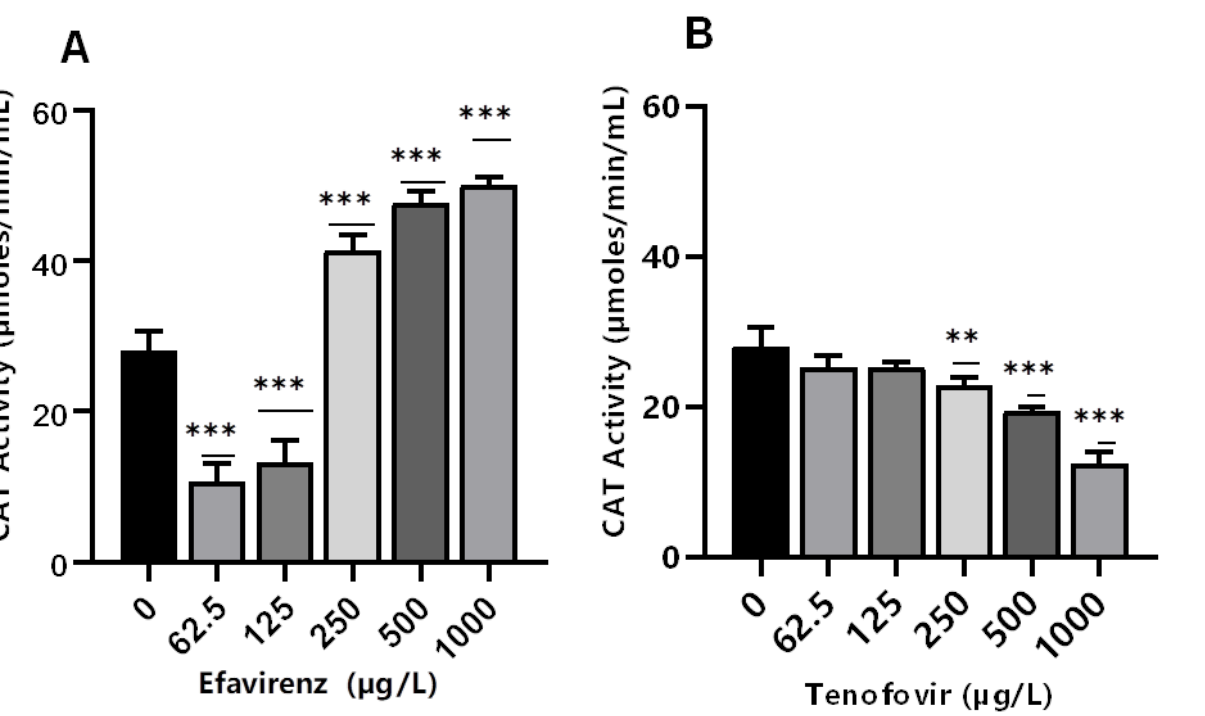
Figure 2. Catalase activity levels in D. magna exposed to ( A ) EFV, and ( B ) TFV for 48 h. Values are presented as mean ± standard deviation ( n = 3); (Asterisks (*) denote significant differences (one-way ANOVA followed by Dunnett’s multiple comparisons test (** p ≤ 0.01, *** p ≤ 0.001)) between ARVs-exposed samples and the controls.